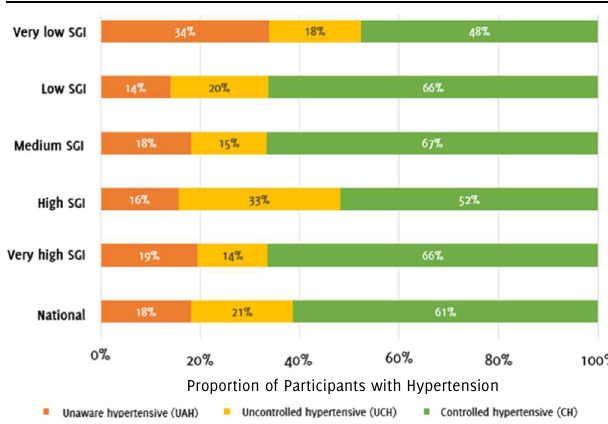
Table 1 . Demographic Characteristics of Participants. Figure 2 . Proportion of Unaware, Uncontrolled and Controlled Hypertensives by Social Gap